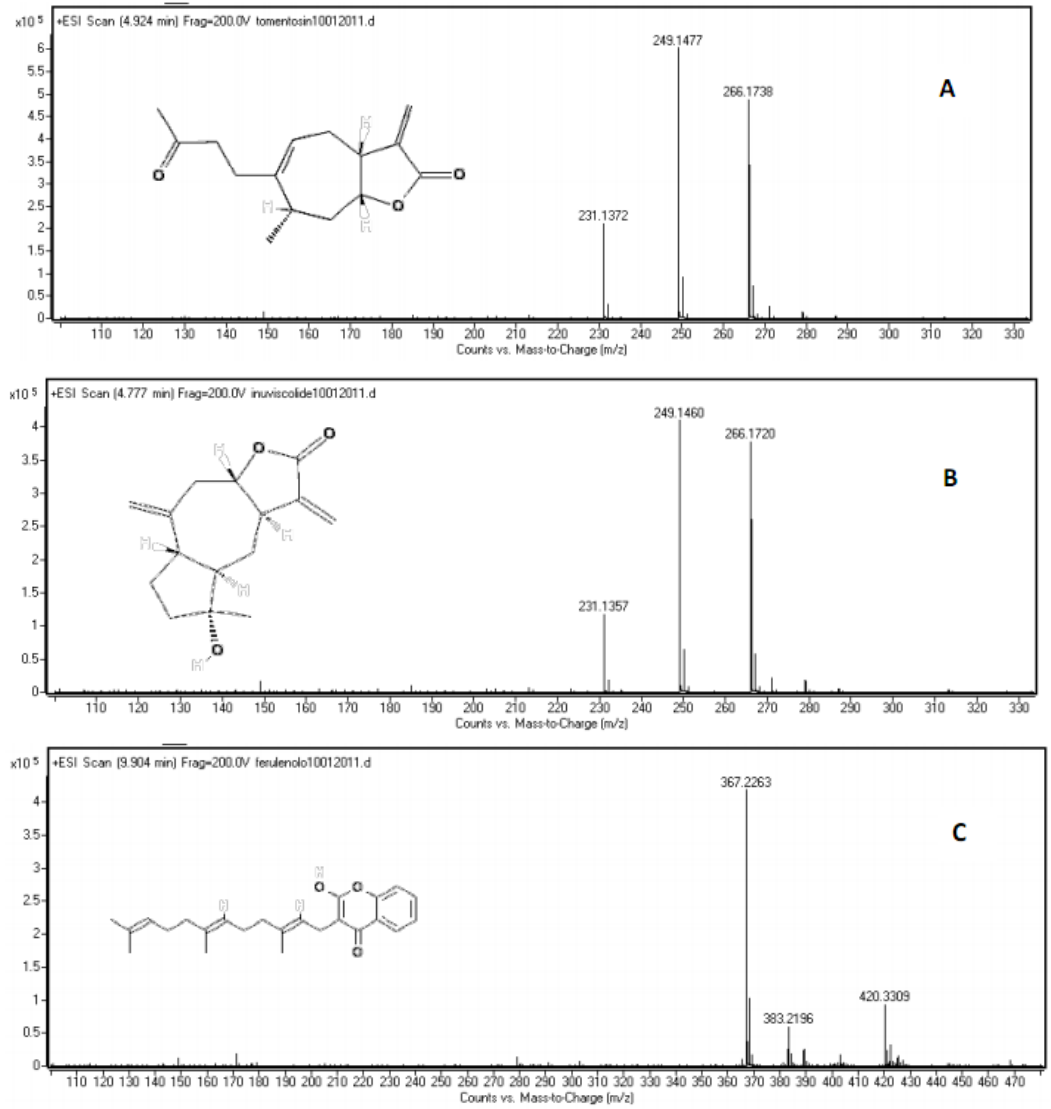
Figure 5. LC-Q-TOF spectra of A) tomentosin, B) inuviscolide, C)